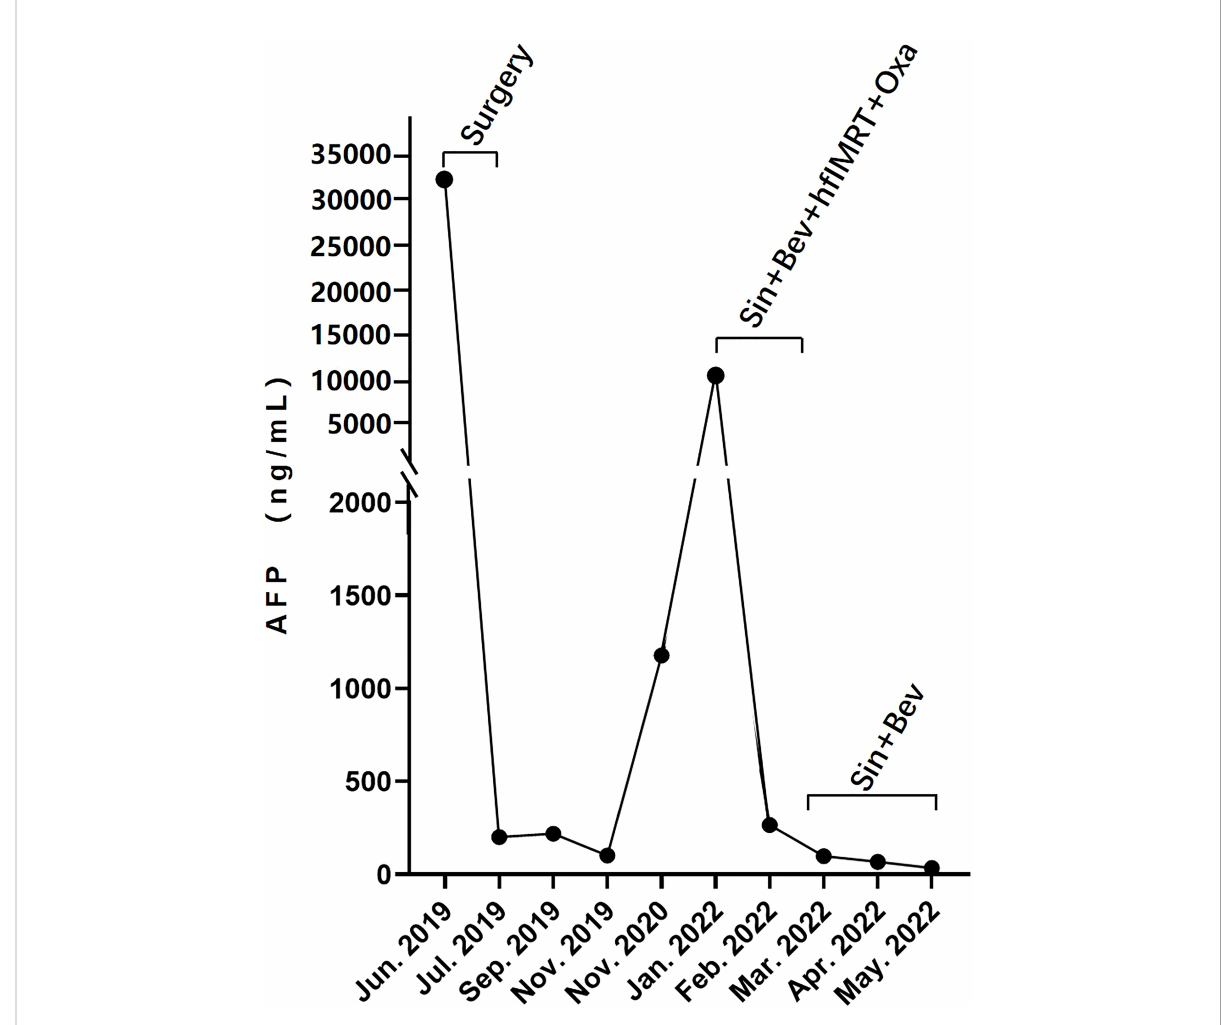
FIGURE 2 The dynamic changes of serous AFP level over time: AFP dropped to <400 ng/ml after surgical removal of an intrahepatic tumor in June 2019 and sintilimab-bevacizumab biosimilar IBI305 – hfIMRT – oxaliplatin combination treatment in February 2022, and continued to decline gradually during the stage of maintenance treatment with sintilimab and bevacizumab biosimilar